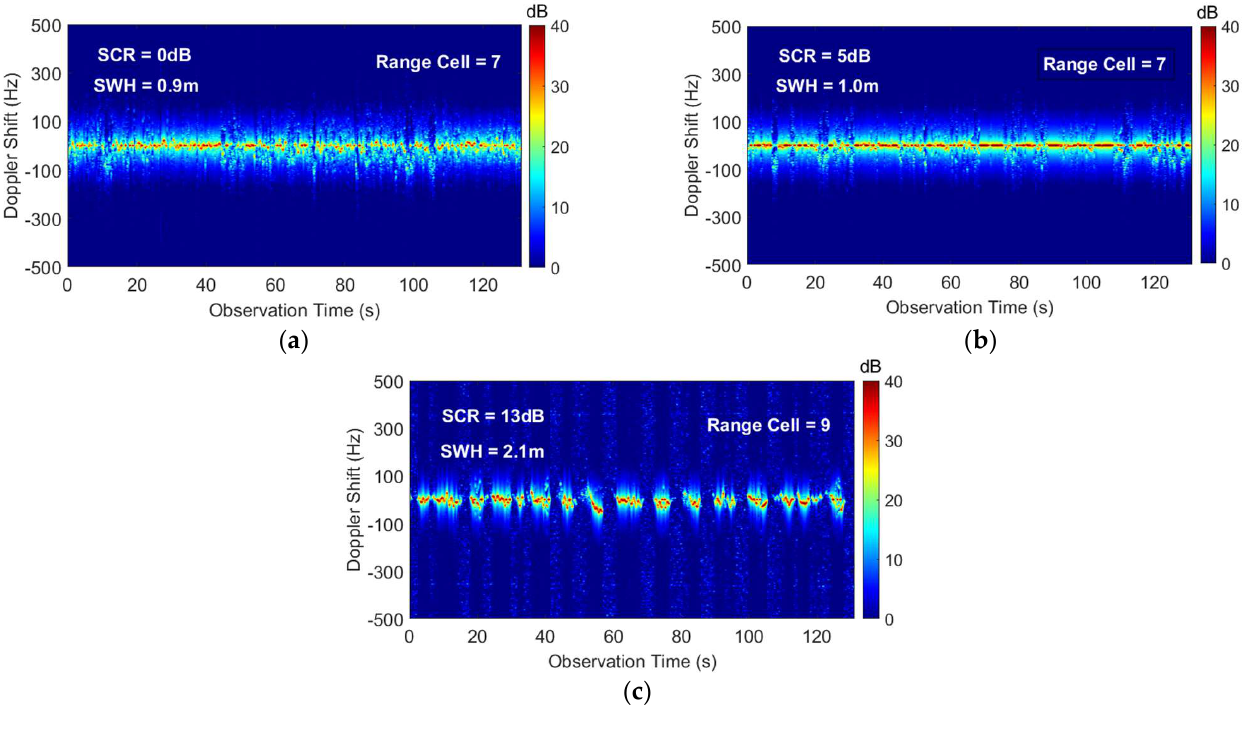
Figure 8. The time‒Doppler spectrum image of the target cell for the IPIX radar data in Table 1. ( a ) Figure 8. The time-Doppler spectrum image of the target cell for the IPIX radar data in Table 1. The #IPIX_01 data; ( b ) The #IPIX_02 data; ( c ) The #IPIX_03 data. ( a ) The #IPIX_01 data; ( b ) The #IPIX_02 data; ( c ) The #IPIX_03 data.